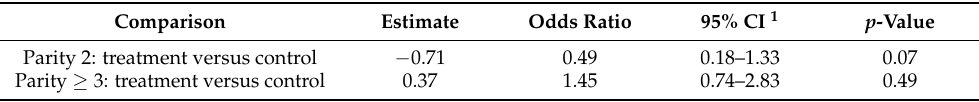
Table 2. Odds of clinical mastitis in the first 60 DIM by parity in a randomized clinical trial evaluating the effect of an oral postpartum calcium supplementation strategy in multiparous Jersey cows ( n = 809) in a dairy in west TX.